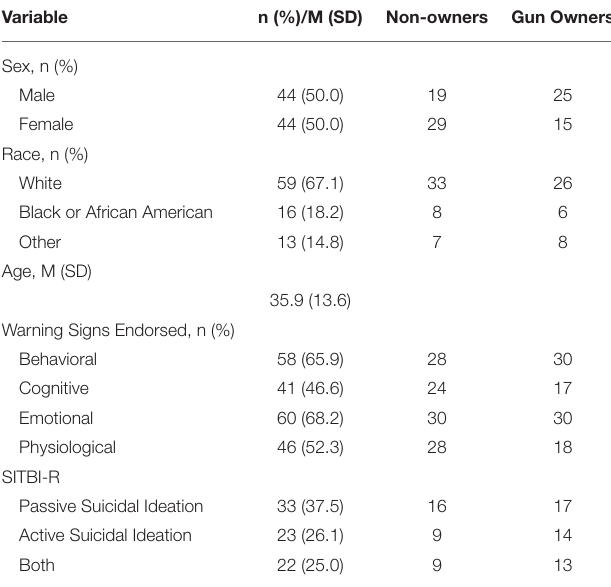
TABLE 2 | Sample characteristics of non-owners and gun owners ( N =